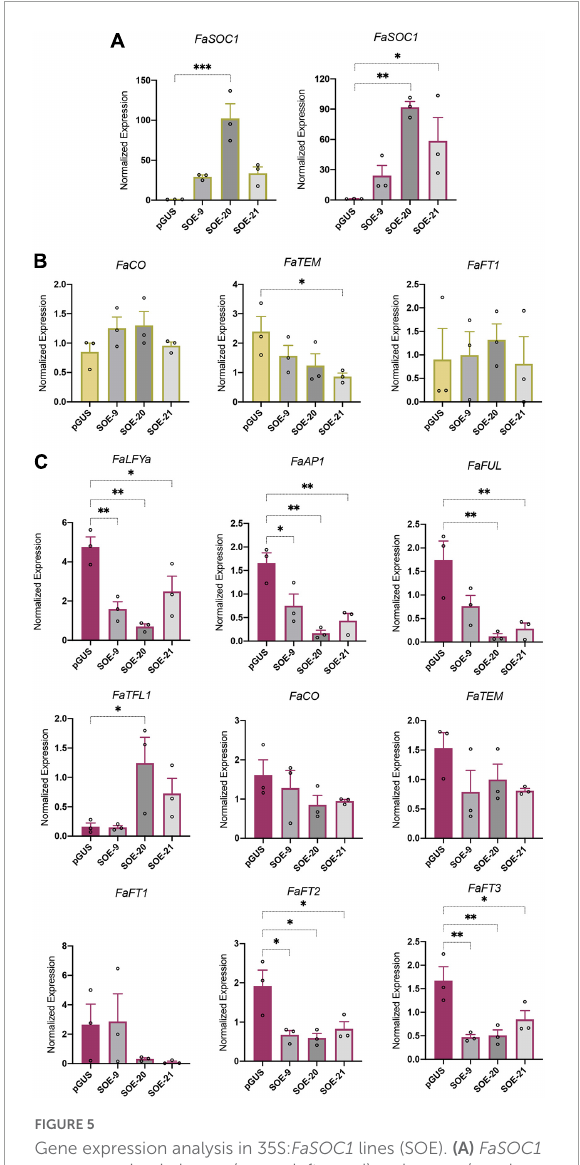
FIGURE5 Gene expression analysis in 35S: FaSOC1 lines (SOE). (A) FaSOC1 overexpression in leaves (green, left panel) and crown (purple, right panel) of three independent SOE lines. (B) FaCO, FaTEM and FaFT1 expression in leaves of SOE lines. (C) Flowering time gene expression in crowns from SOE lines. All samples were collected under natural SD (9 h52 min/14 h17 min day/night; average maximum and minimum temperature from previous 4 weeks: 21.1/10.6 ◦ C) conditions at ZT3. Graphs show the average of normalized values from three biological replicates ± SEM. In each bar, dots represent the normalized value of each biological replicate. * p < 0 . 05, ** p < 0 . 01, *** p < 0 .